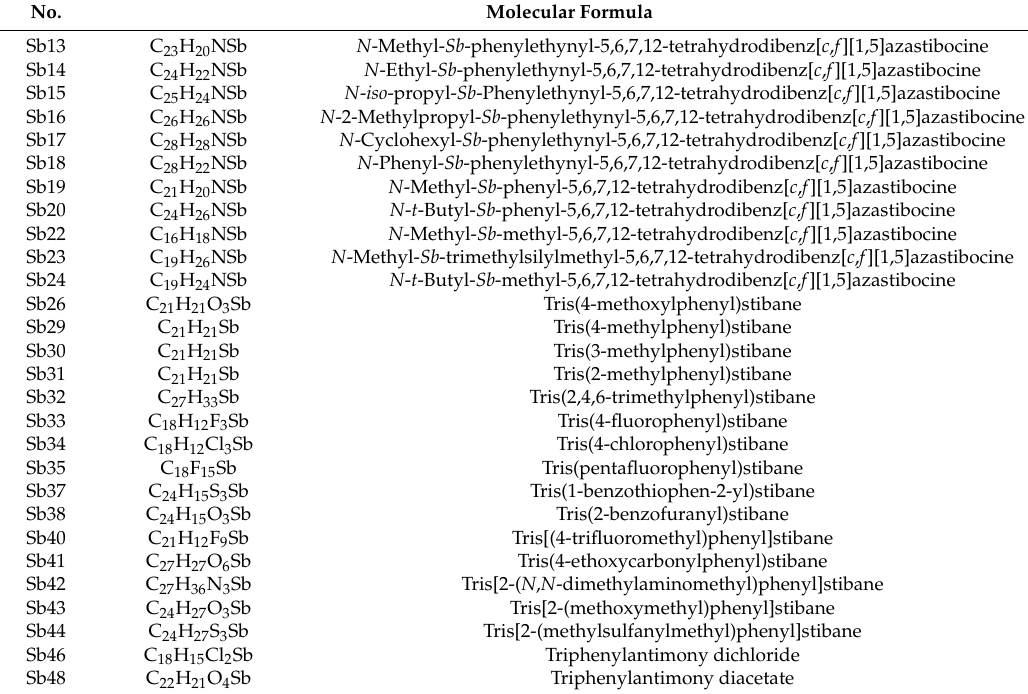
Table 1. Organoantimony compounds used in this